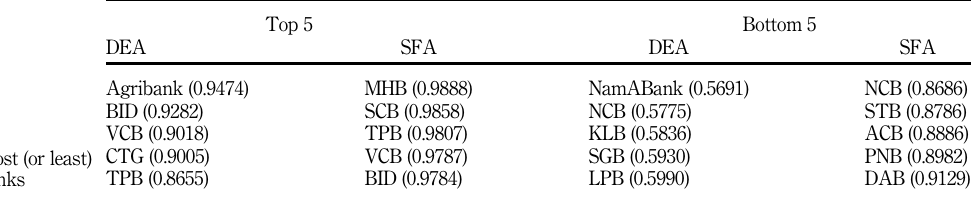
Table 7. The five most (or least) efficient